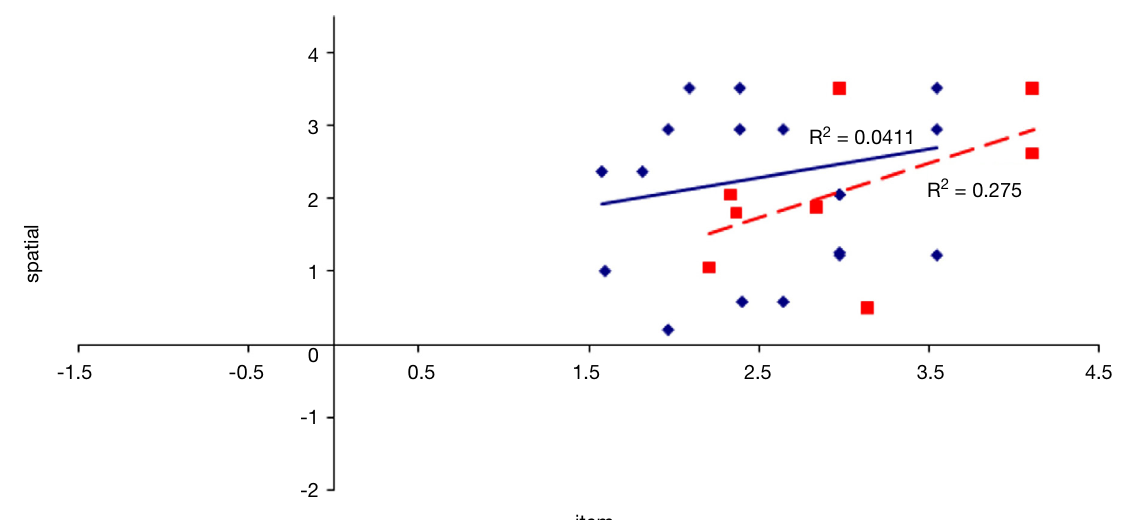
Figure 16 | Scatter plot of performance on the item and spatial tasks with linear fi t and R -squared values for control (Experiment 1, in red squares and dashed line) and college-age (Experiment 3, in blue circles and solid line) participants. Neither correlation is signifi cant.